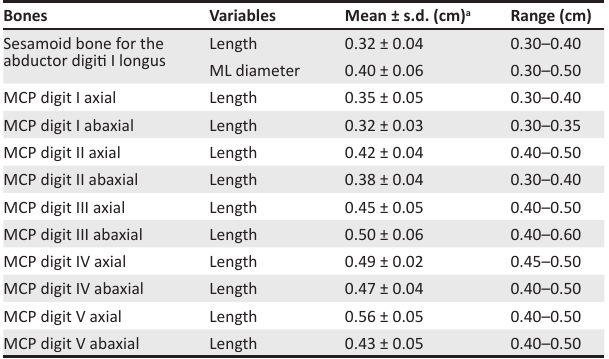
TABLE 3: Radiographic measurements of the sesamoid bones in captive red pandas. Bones